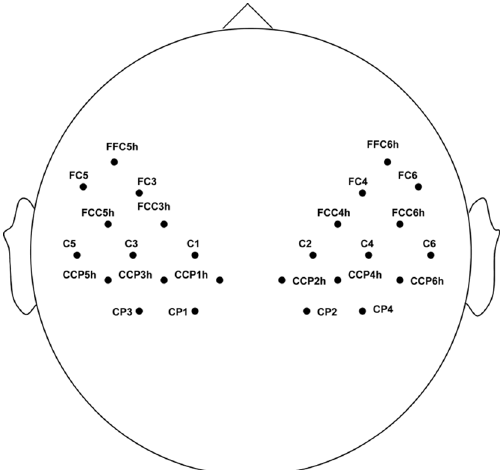
Fig 4. Distribution of the lateral electrodes where EEG is suppressed under OI and NI